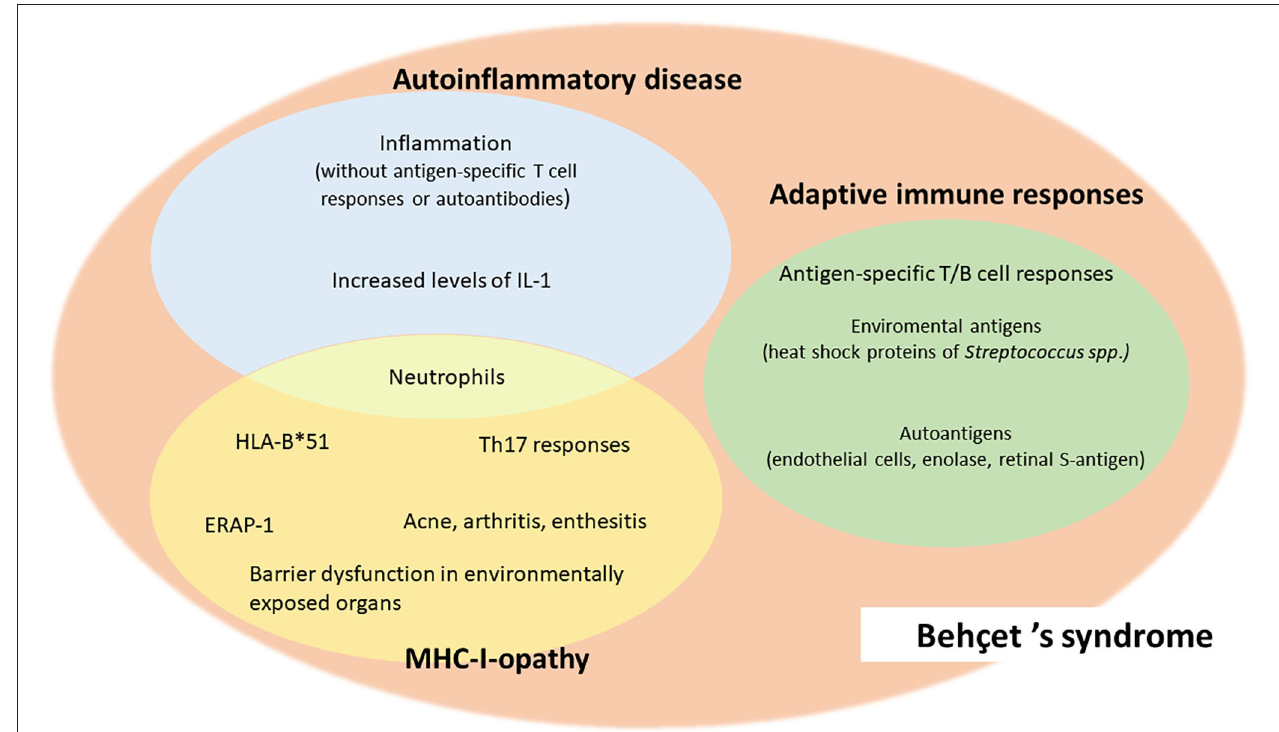
FIGURE 1 | Common features of Behçet’s syndrome and autoimmune diseases, autoinflammatory diseases and